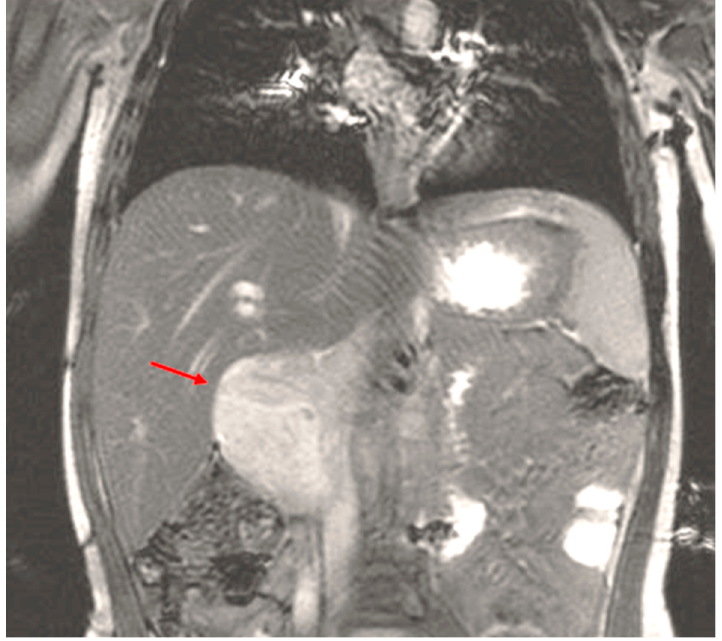
Figure 4. MRI (Coronal View) of patient with hepatobiliary embryonal rhabdomyosarcoma (RMS) (red arrow).